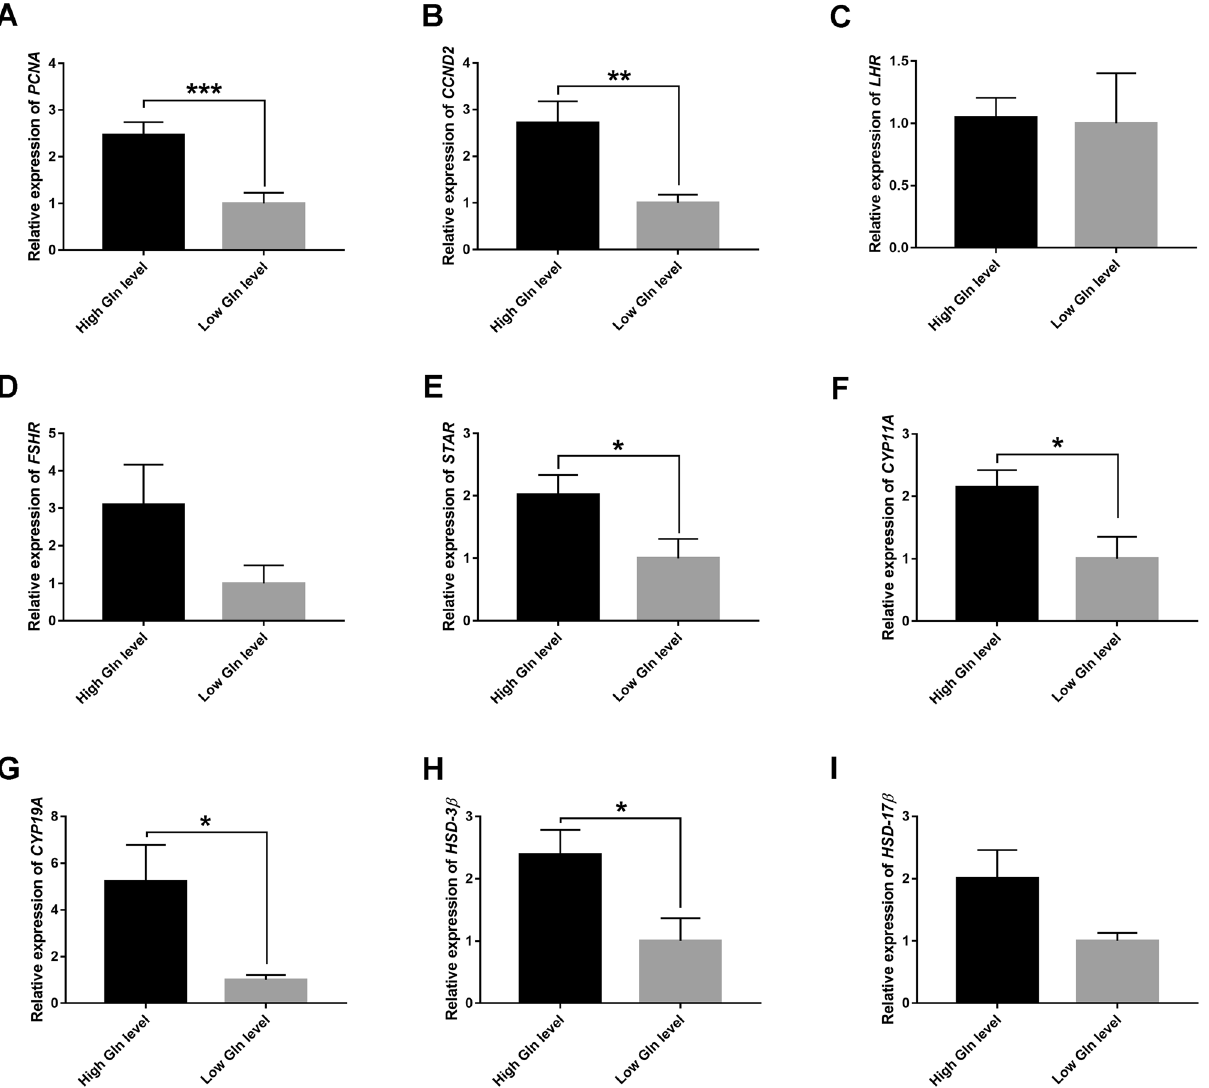
Figure 2. The mRNA expression of proliferation, gonadotropin receptor and sex steroid hormone synthesis- related genes in cumulus granulosa cells between high and low glutamine (Gln) level groups. ( A , B ) The column charts show the PCNA and CCND2 mRNA expression in granulosa cells (GCs) in the two groups. ( C , D ) The column charts display the LHR and FSHR mRNA expression in the two groups. ( E – I ) The mRNA expression of sex steroid hormone synthesis-related genes in the two groups, including STAR, CYP11A, CYP19A, HSD-3β and HSD-17β. Data represent the mean values ± standard error of the mean (mean ± SEM). High Gln level group, n = 14; Low Gln level group, n = 13. All indicated P values were determined by Student’s t-test. * P value < 0.05; ** P value < 0.01; *** P value <